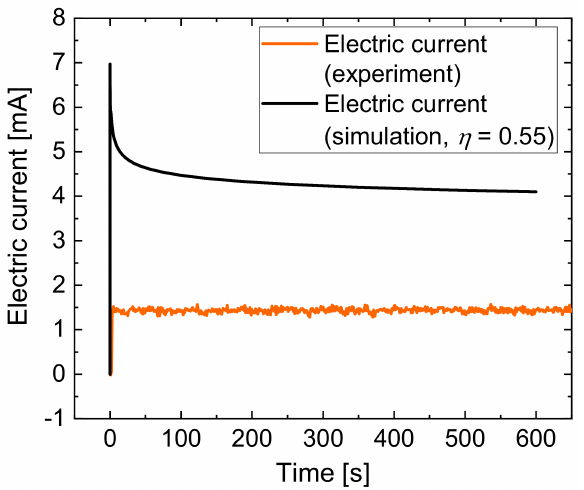
Figure 12. Comparison of the experimentally determined and the calculated electric current during jet-based